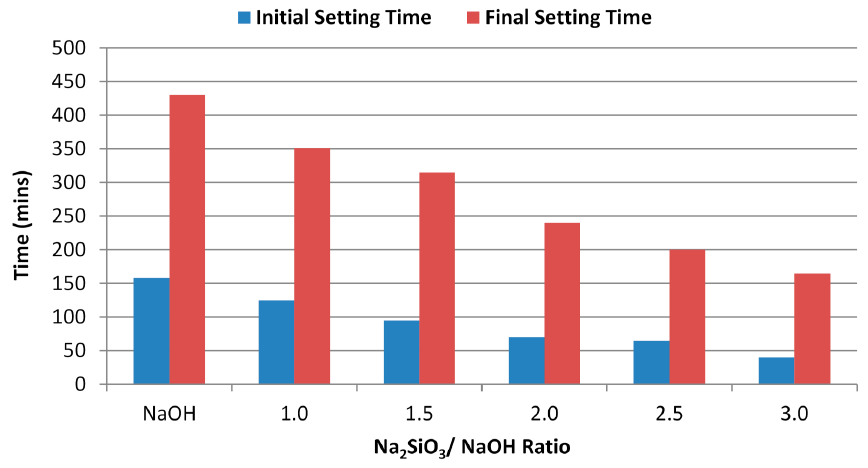
Figure 8. Setting time of alkali-activated POFA paste at different Na 2 SiO 3 /NaOH